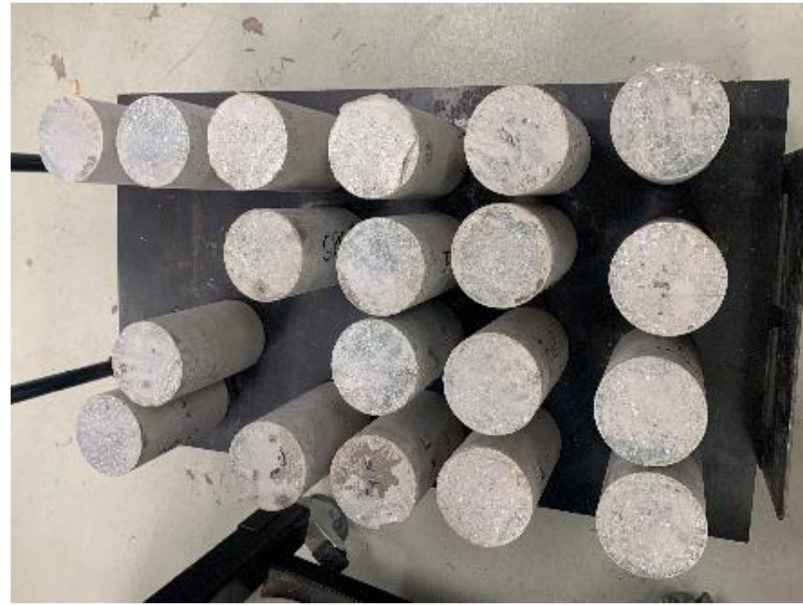
Figure 3. Hardened SCGC